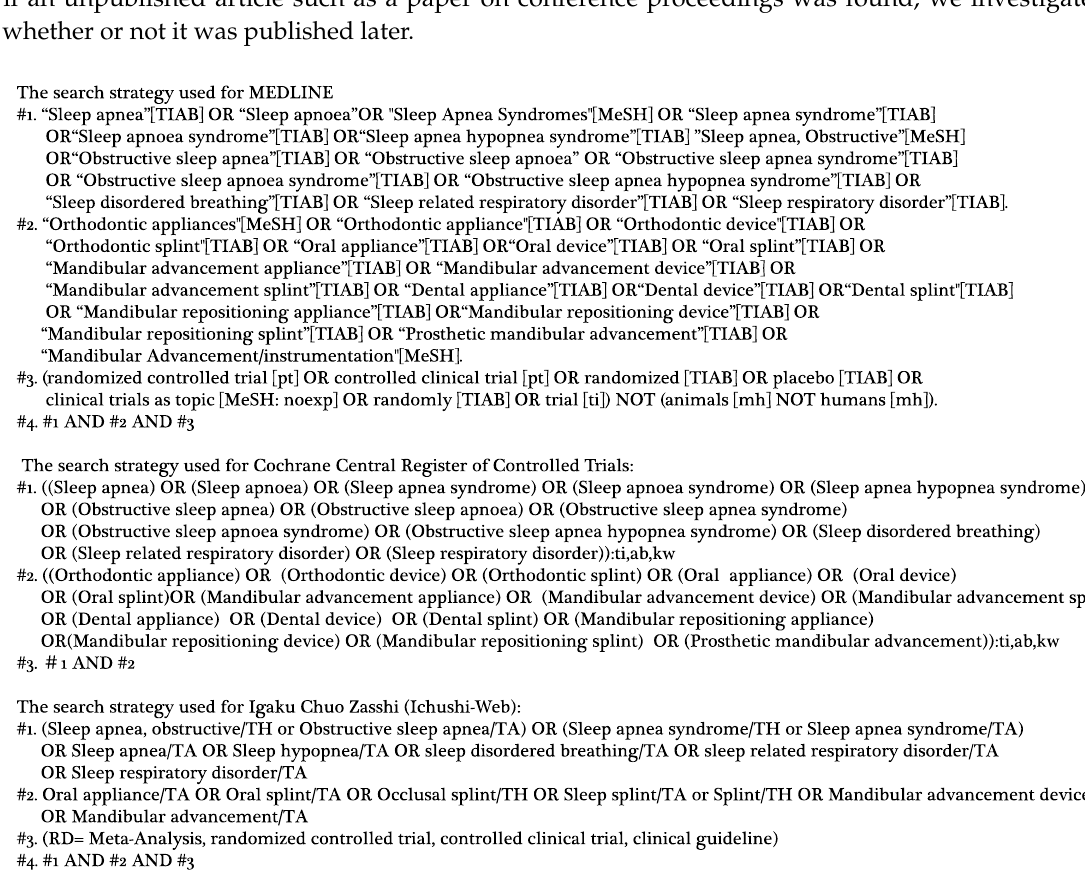
Figure 1. The search strategy used in this systematic review.